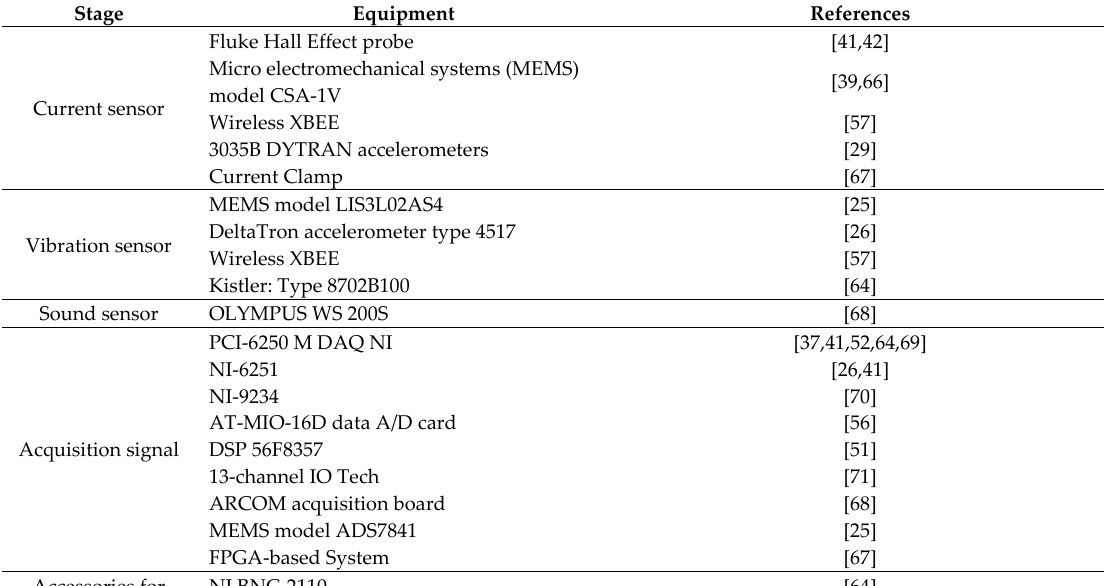
Figure 6. Stages of the process for the monitoring, detection and diagnosis of early failures. Fault diagnosis through WPD, FFT and ANN, as shown in [64]. Reproduced with permission from Springer, 2017. Table 11. Software and hardware used according to the stage of the diagnostic